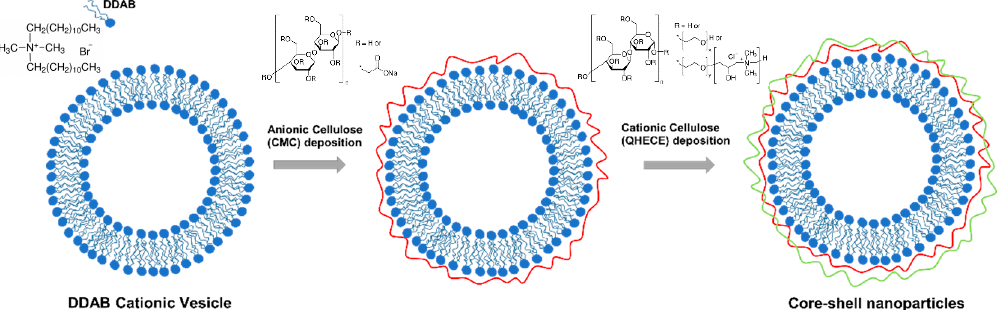
Figure 1. Schematic representation of the alternating LbL deposition of anionic carboxymethylcellulose (CMC) and cationic quaternized hydroxyethylcellulose ethoxylate (QHECE) unto a cationic dimethyldioctadecylammonium bromide (DDAB) vesicle.